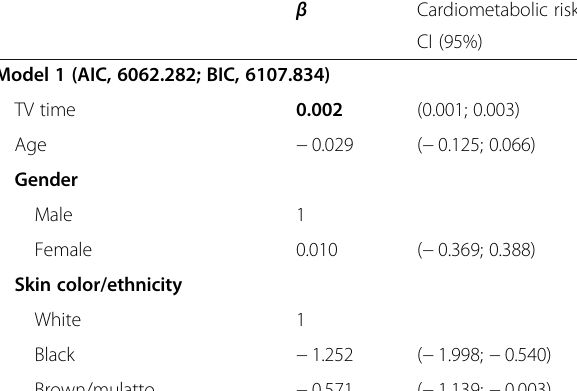
Table 3 Regression analysis between TV time, age, gender, and skin color/ethnicity with cardiometabolic risk in adolescents β Cardiometabolic